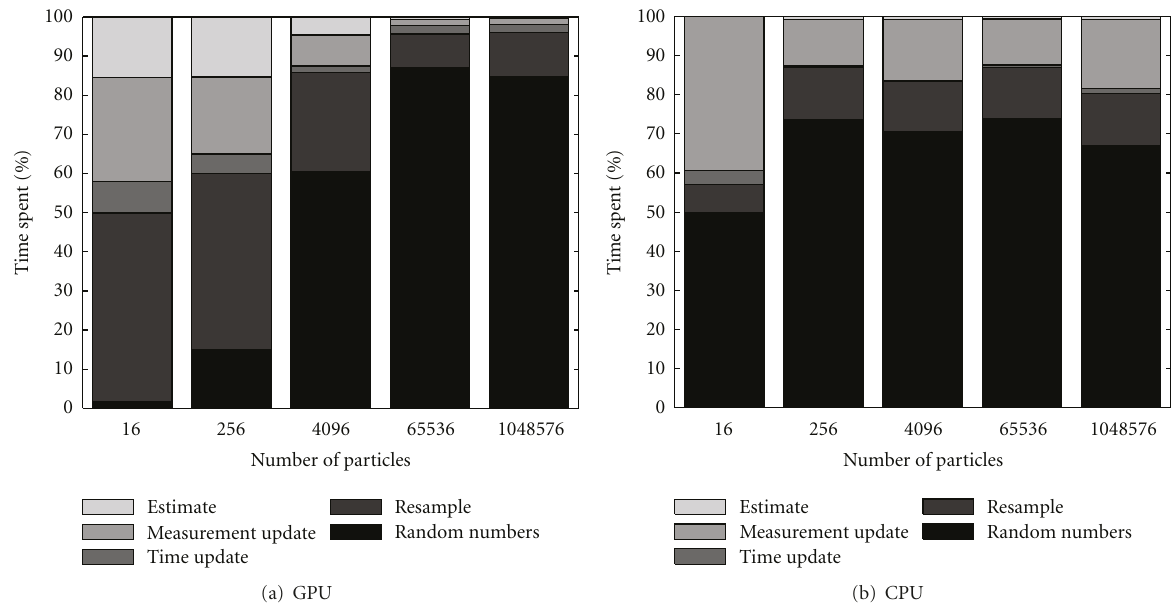
Figure 9: Comparison of the relative time spent in the di ff erent steps particle filter, in the GPU and CPU implementation, respectively.